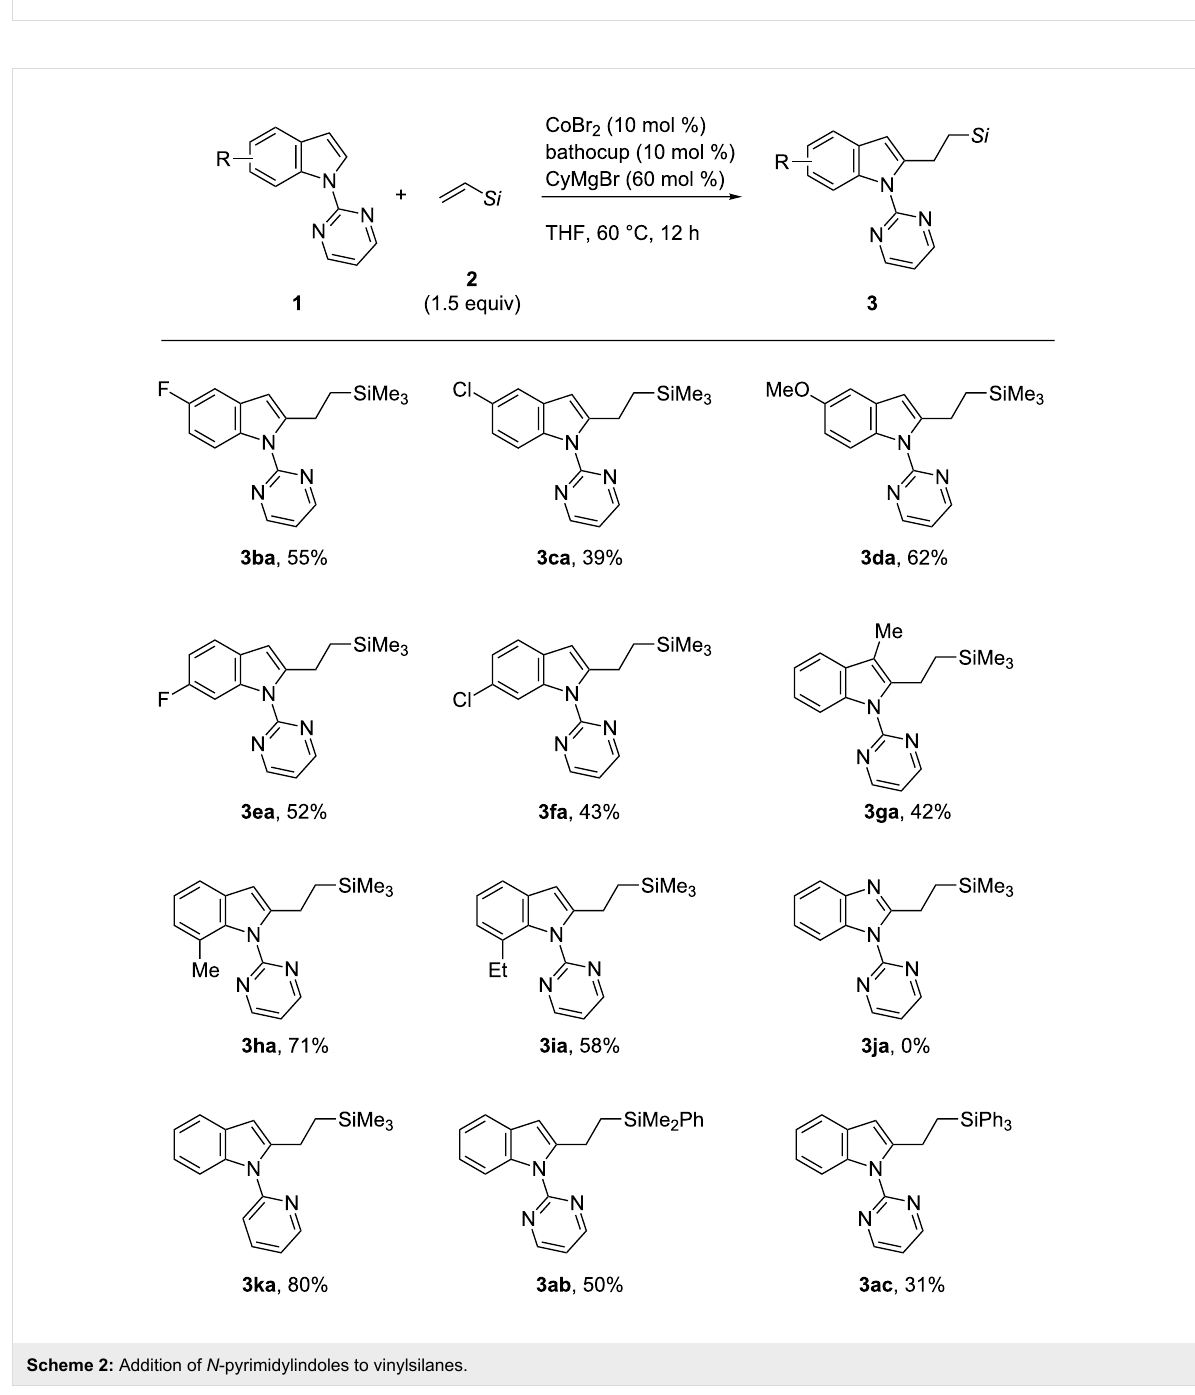
Scheme 2: Addition of N -pyrimidylindoles to